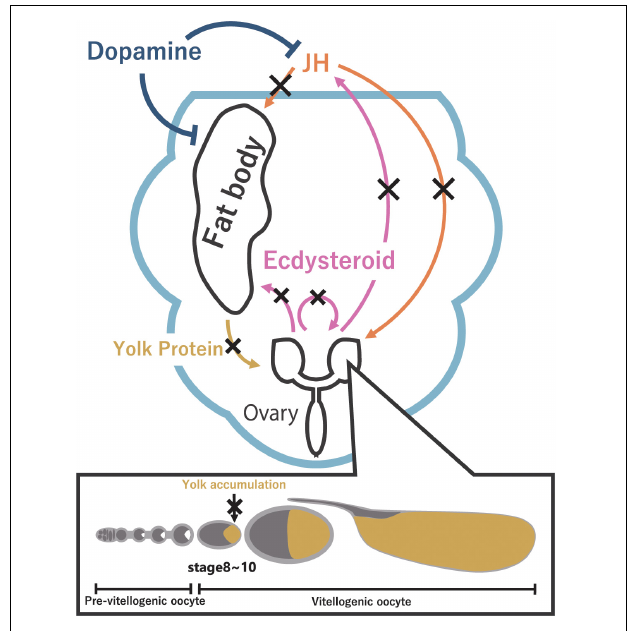
FIGURE 2 | Reproductive dormancy is regulated by JH through the production of yolk protein in the fat body. JH (orange) promotes the production of yolk protein in the fat body and the uptake of yolk protein in the ovary. On the other hand, ecdysteroids (pink) promote yolk protein production in the fat body, affect JH biosynthesis in the CA, and regulate oogenesis. Under dormancy-inducing conditions, a decrease in JH level and ecdysteroid level suppresses the yolk protein accumulation (dark yellow) in oocytes, leading to reproductive dormancy. Furthermore, dopamine (dark blue) might be involved in inducing reproductive dormancy via yolk protein production in the fat